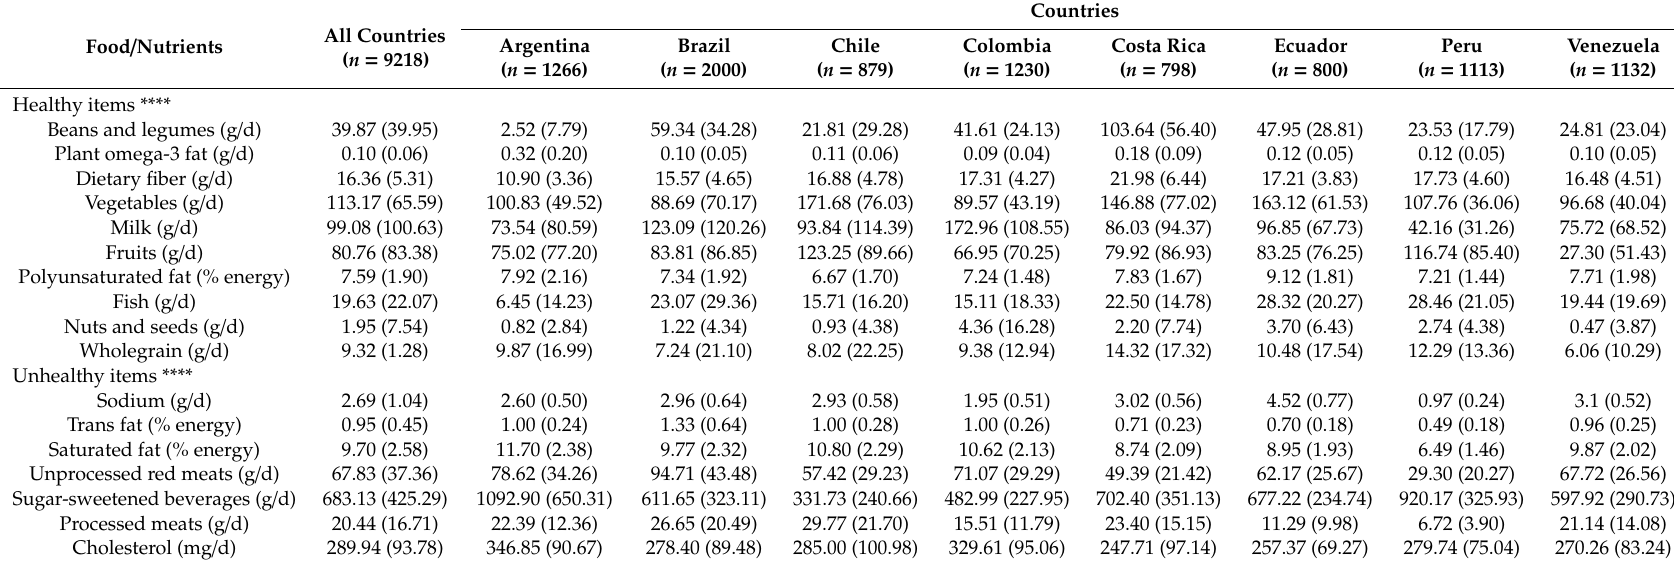
Table 2. Dietary consumption of foods groups and nutrients in individuals residing in urban areas of Latin American countries ( n = 9218).